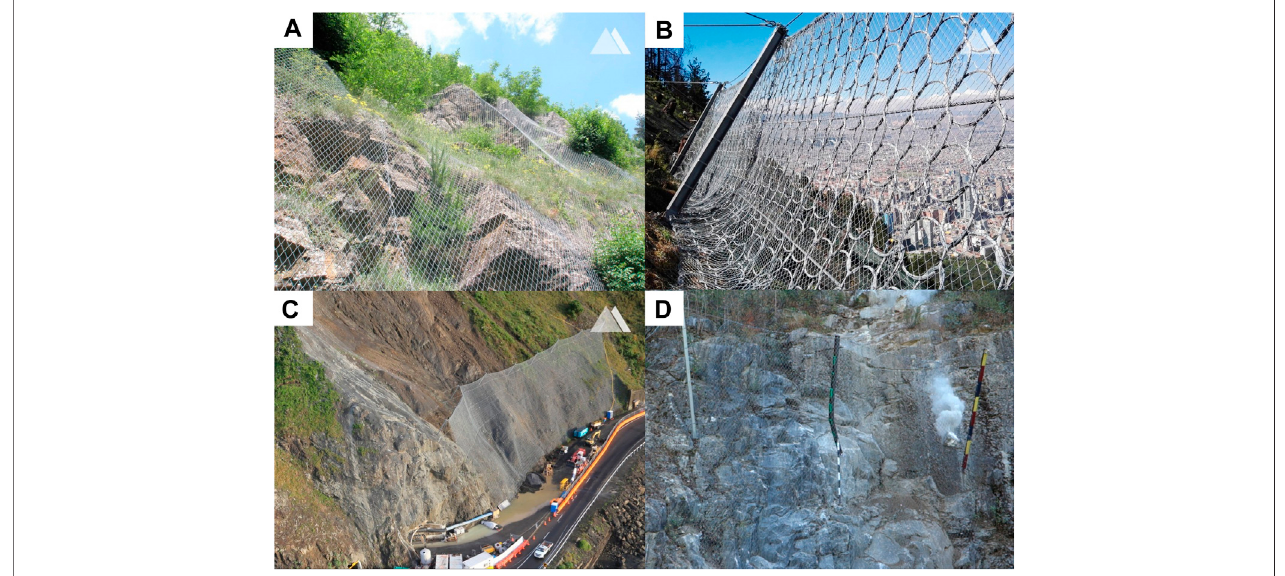
FIGURE 1 | All photos are property of Geobrugg (www.geobrugg.com). (A) Banya railway rockfall protection. (B) Monserrate walking path. (C) Kaikoura State Highway, Attenuator barrier. (D) Attenuator barrier after impact. Photo of the experiment discussed in section 3